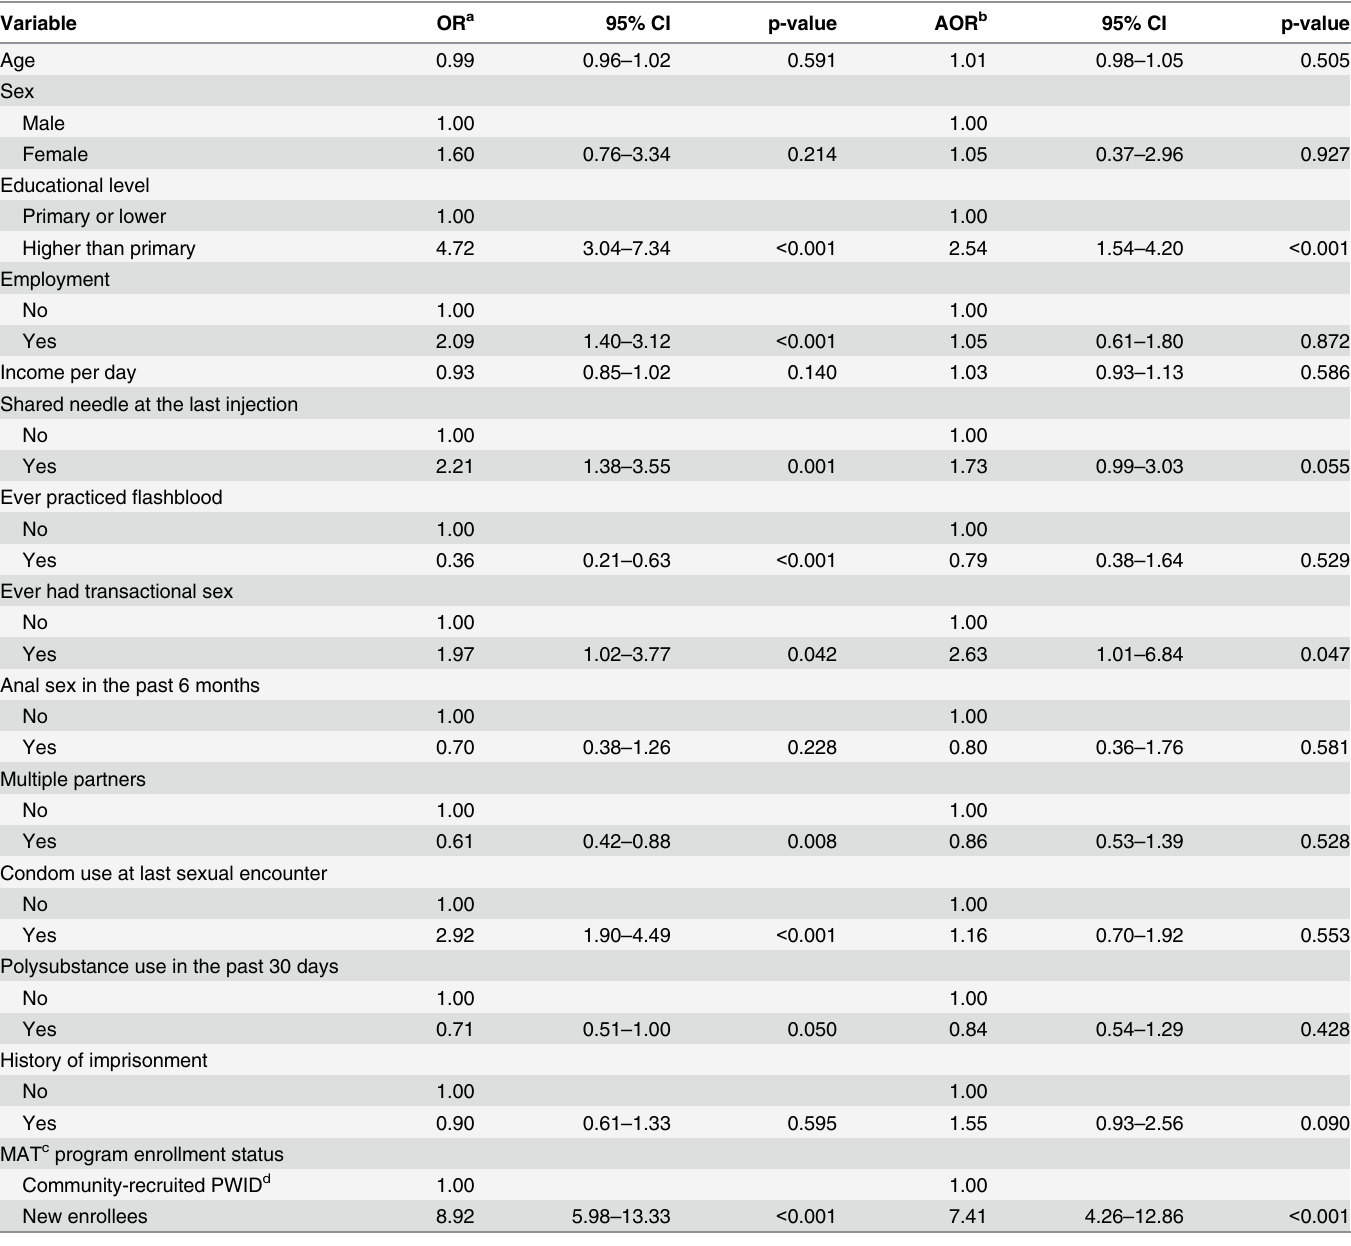
Table 3. Factors associated with ever being screened for HIV among